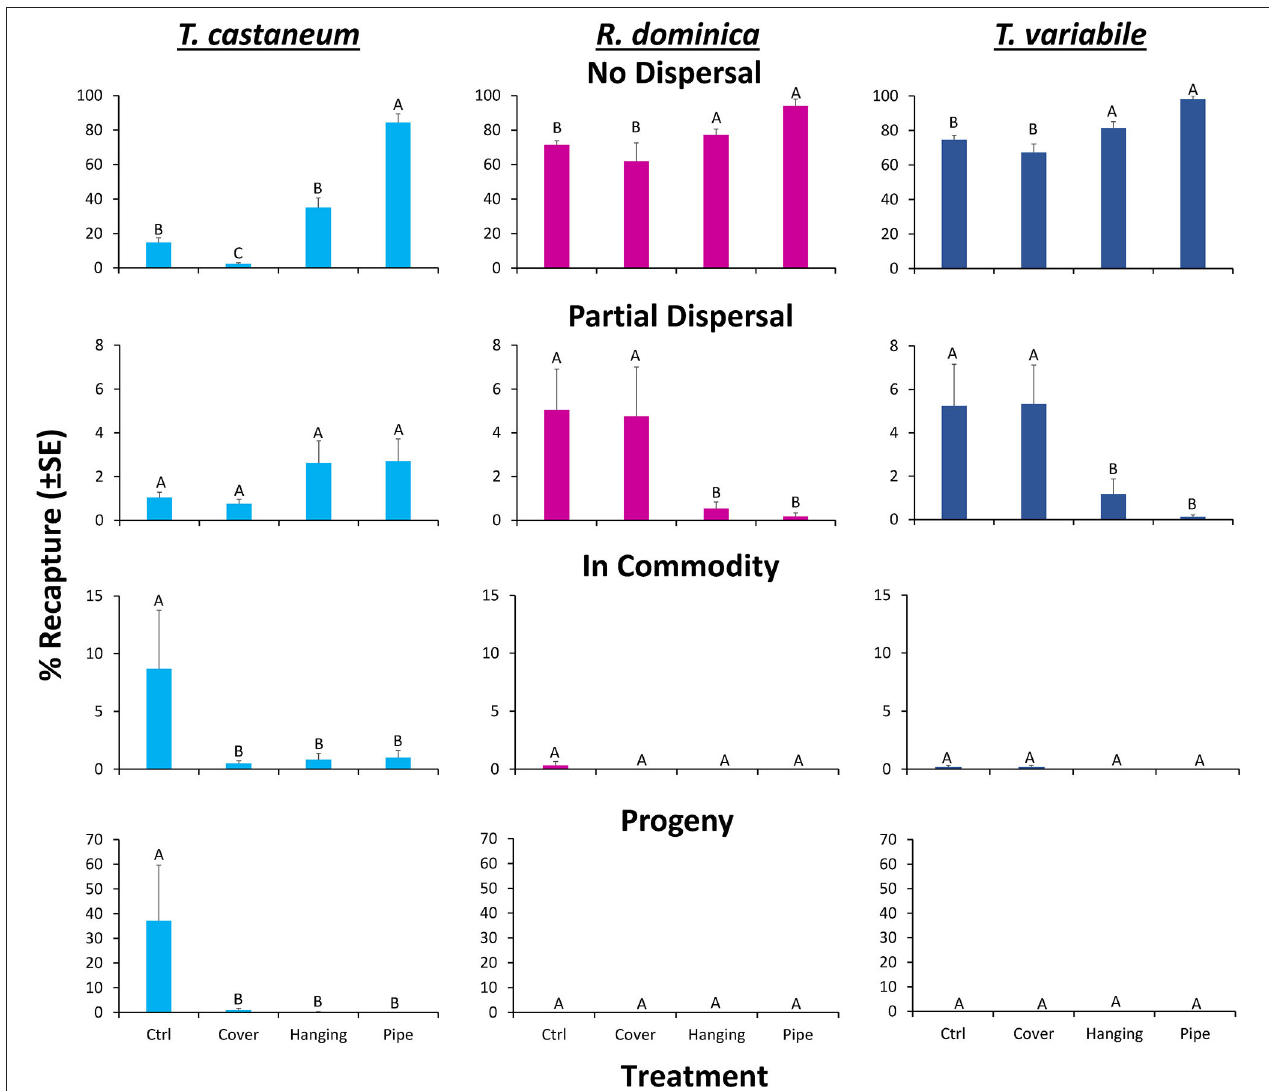
FIGURE 8 | Mean ( ± SE) percentage of 100 T. castaneum (light blue bars), R. dominica (pink bars), and T. variabile (dark blue bars) adults released in pilot-scale warehouses in Manhattan, KS during 2019 recaptured after 72h for Trial 1 to assess relative efficacy of different LLIN deployment methods. Individuals were recorded as not dispersing (Zone 6, top row), partially dispersing (Zones 2–5, second row), infesting the commodity (Zone 1, third row), or producing progeny after a 6-week holding period (bottom row). Deployment methods included: Cover—covering the commodity directly with LLIN, Hanging—a single piece of LLIN bisecting the warehouse, Pipe—a piece of LLIN bisecting a PVC pipe with adults released in the pipe, and Ctrl—no deployment of LLIN. Bars with shared letters are not significantly different from each other (Tukey HSD, α =